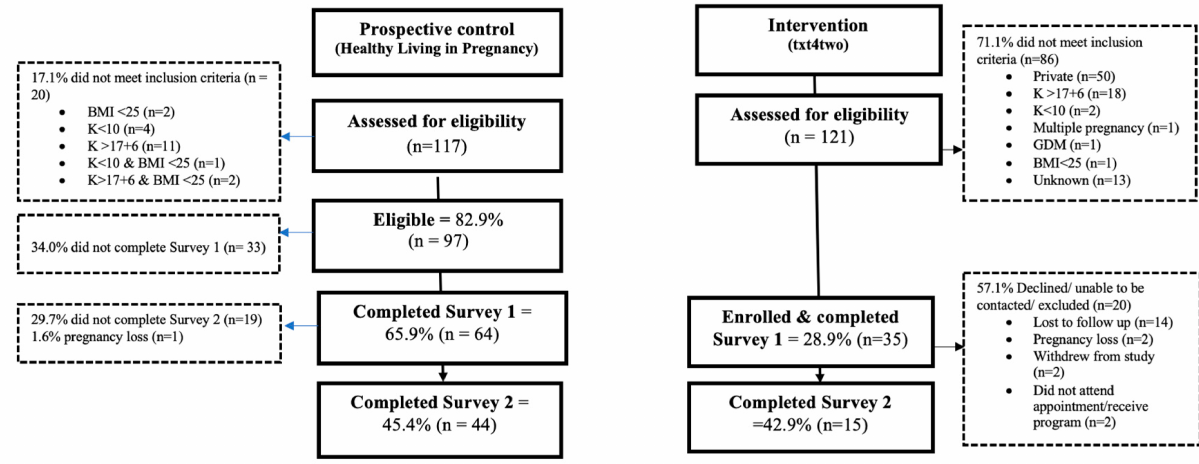
Figure 1. Recruitment flowchart for the prospective control and txt4two (intervention)